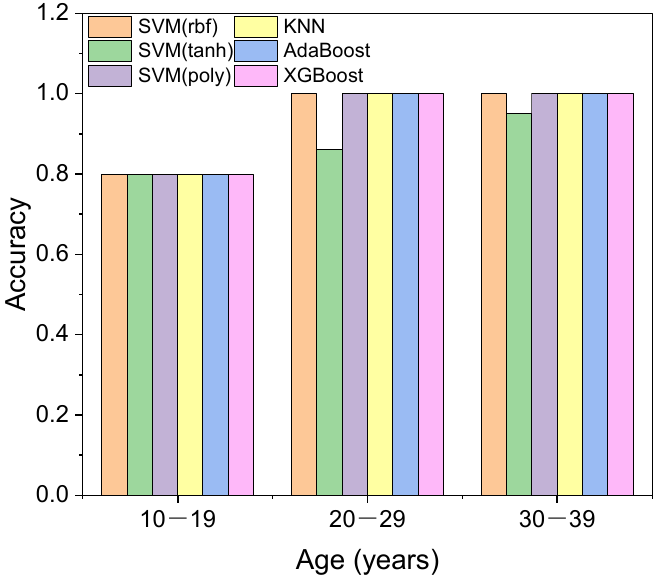
Figure 8. The accuracy of models in terms of the service time of